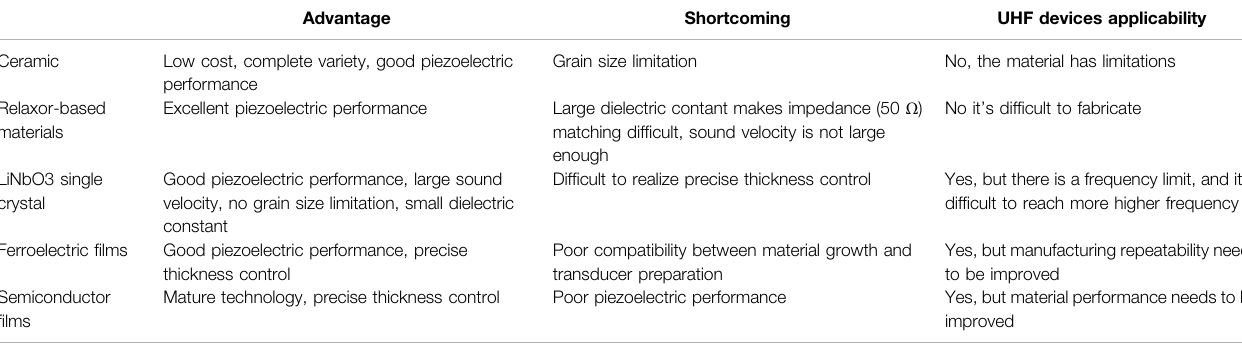
TABLE 3 | Material analysis summary.